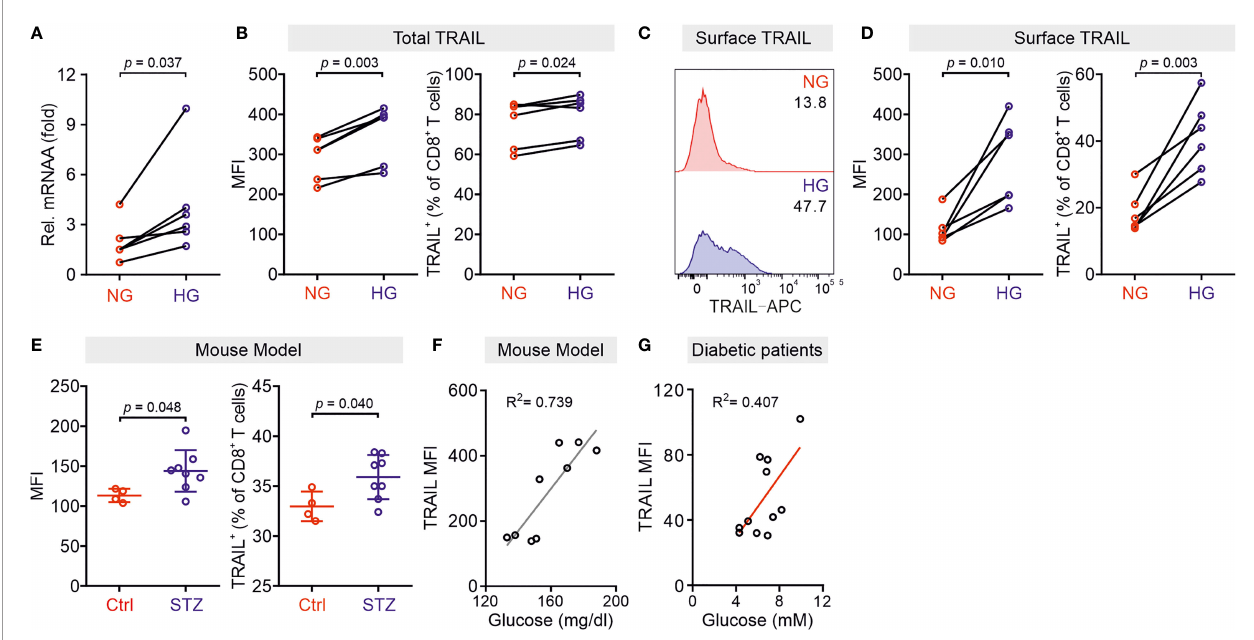
FIGURE 1 | TRAIL is up-regulated in CTLs in environments with high glucose. Primary human CD8 + T cells were stimulated with CD3/CD28 beads for 3 days in NG (5.6 mM) or HG (25 mM) medium. (A) Relative mRNA expression levels of TRAIL in CTLs were quanti fi ed by qRT-PCR (n = 6 donors from three independent experiments). (B – D) Expression of TRAIL in CTLs was detected by fl ow cytometry. CTLs were stained with the antibodies against CD8 and TRAIL following permeabilization (B) or without permeabilization (C, D) for total or surface protein level of TRAIL (n = 6 donors from three independent experiments). (E, F) TRAIL is up-regulated in diabetic mice. Mouse splenocytes were isolated and stained with PE-mCD3, BV421-mCD8, and APC-mTRAIL for analysis using fl ow cytometry (Ctrl = 4, STZ mice = 8). Data are represented as Mean ± SD. Correlation of TRAIL expression in CD8 + T cells and blood glucose is shown in (F, G) Positive correlation of TRAIL expression in freshly isolated CD8 + T cells from 11 diabetic patients with the blood glucose levels from ten independent experiments. MFI, mean fl uorescent intensity. Data were analyzed by two-tailed paired Student ’ s t test (A, B, D) , two-tailed unpaired Student ’ s t test (E) , trendline analysis (F) , or Pearson ’ s correlation coef fi cient analysis (G) . Connected lines are the data from the same